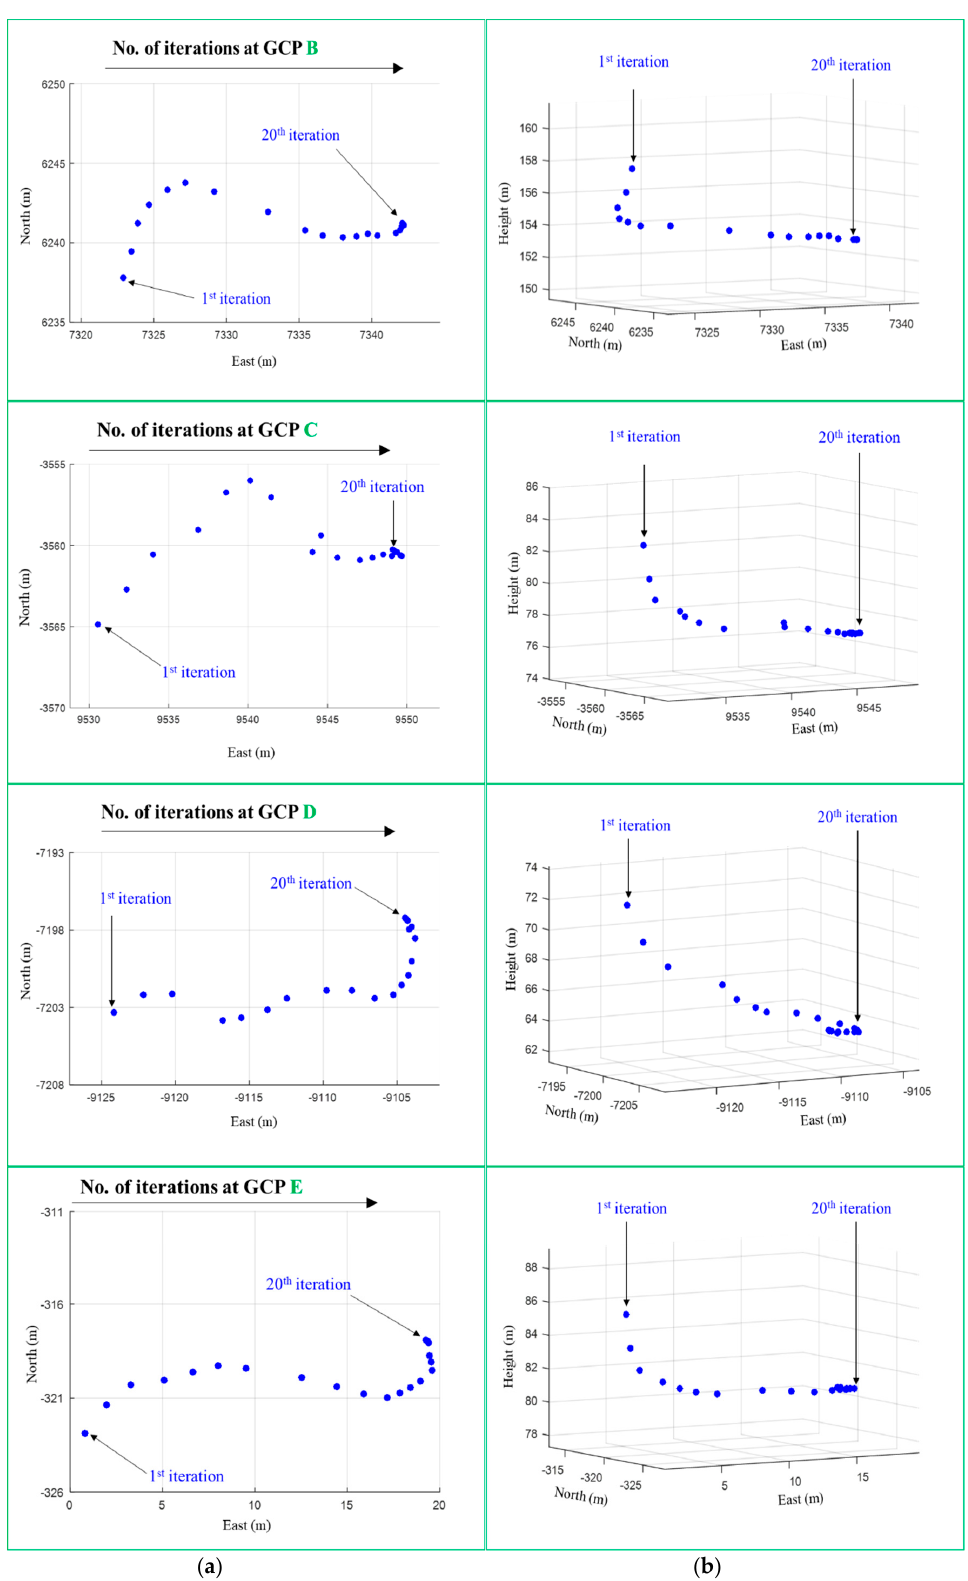
Figure 12. ( a ) horizontal (left column) and ( b ) vertical (right column) movement of the points over all iteration steps. For the visualization of the vertical movement, a 3D view was selected in which the influence of the horizontal component of the movement can still be